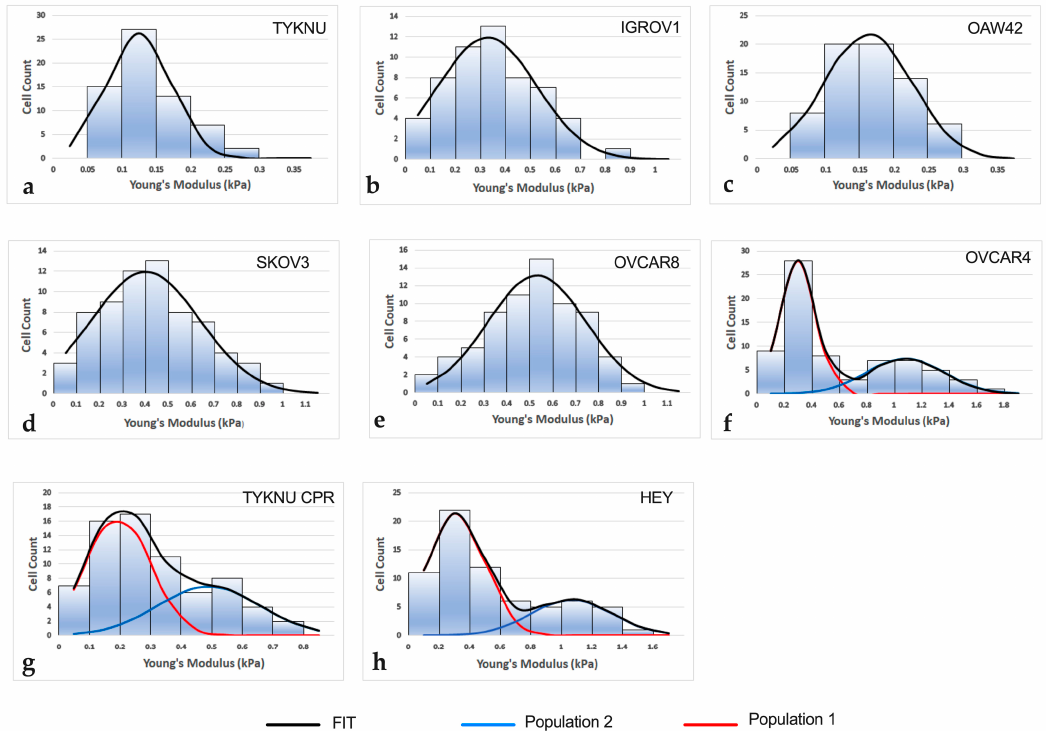
Figure 7. Histograms of cell lines with Gaussian stiffness distribution after 2c treatment ( a – e ). Histograms of cell lines with bimodal stiffness distribution after 2c treatment ( f – h ). FIT: fitting by peak deconvolution method. Population 1: lowest ‐ stiffness population; Population 2: highest ‐ stiffness population.